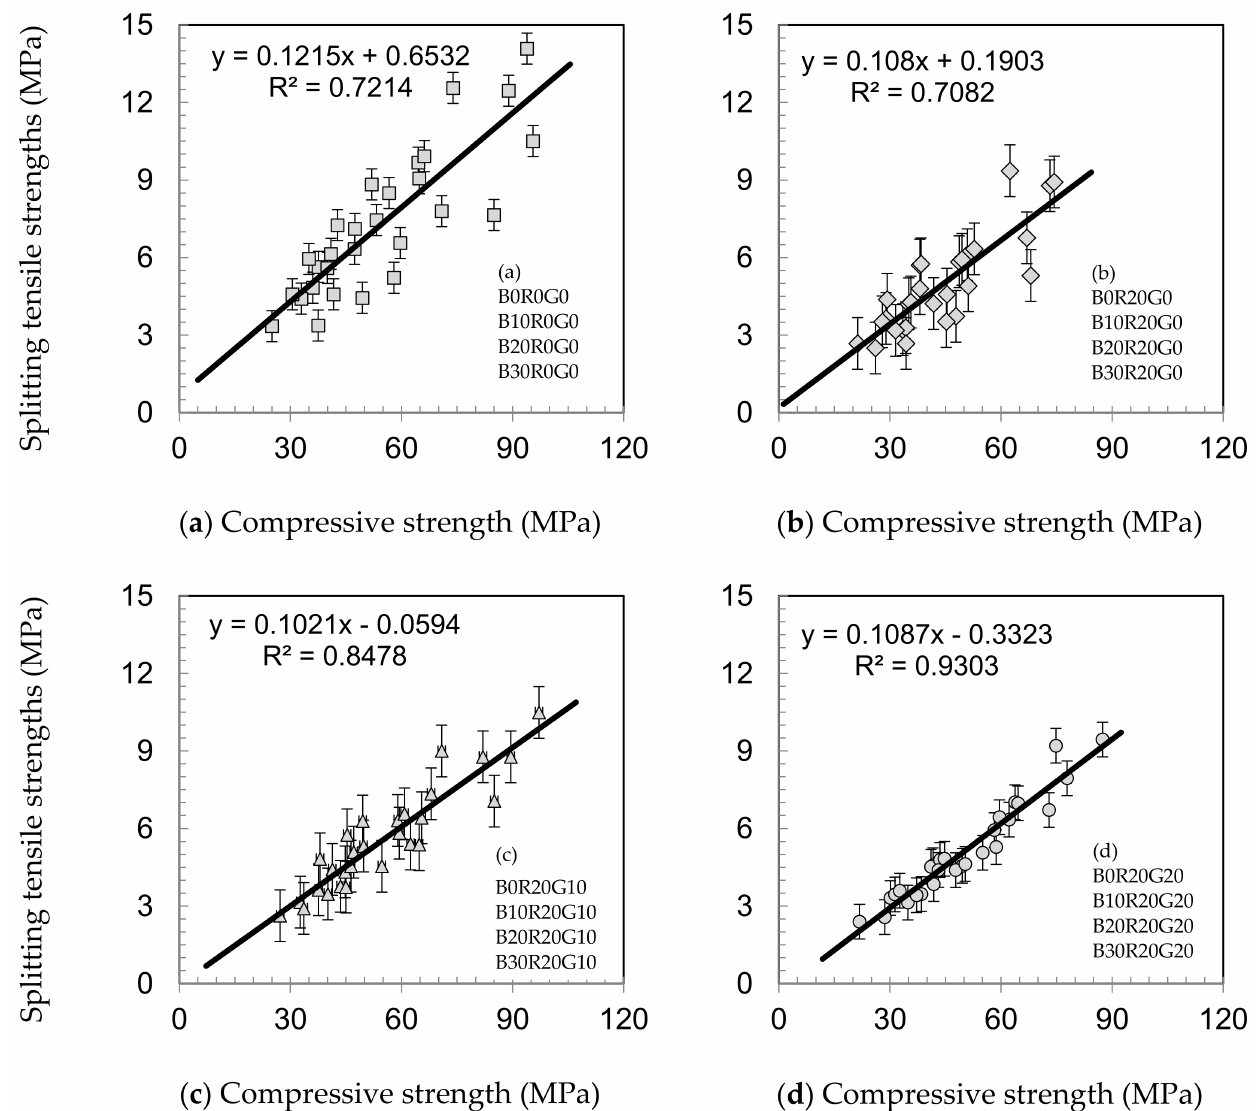
Figure 5. Relationships between splitting tensile strengths as a proportion of compressive strengths of concretes. ( a ) with BA, ( b ) with BA+20%RHA, ( c ) with BA+20%RHA+10%GCW, and ( d ) with